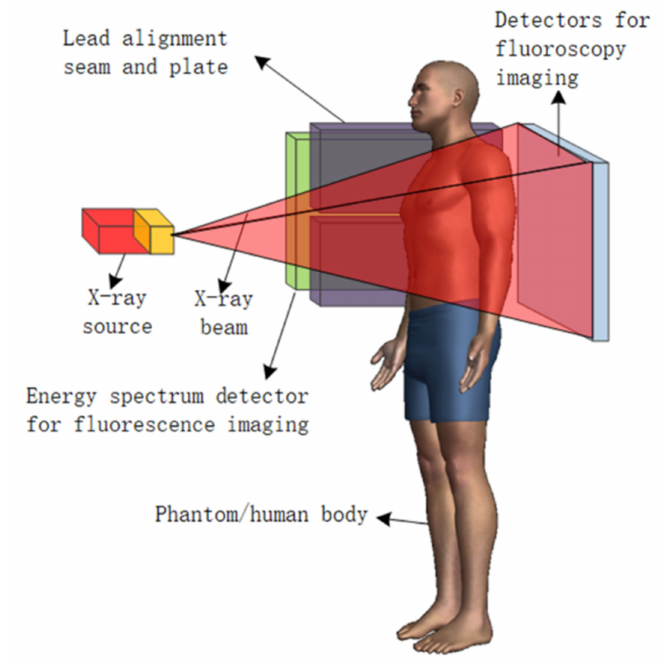
Figure 2. Schematic diagram of cone-beam collimation method.